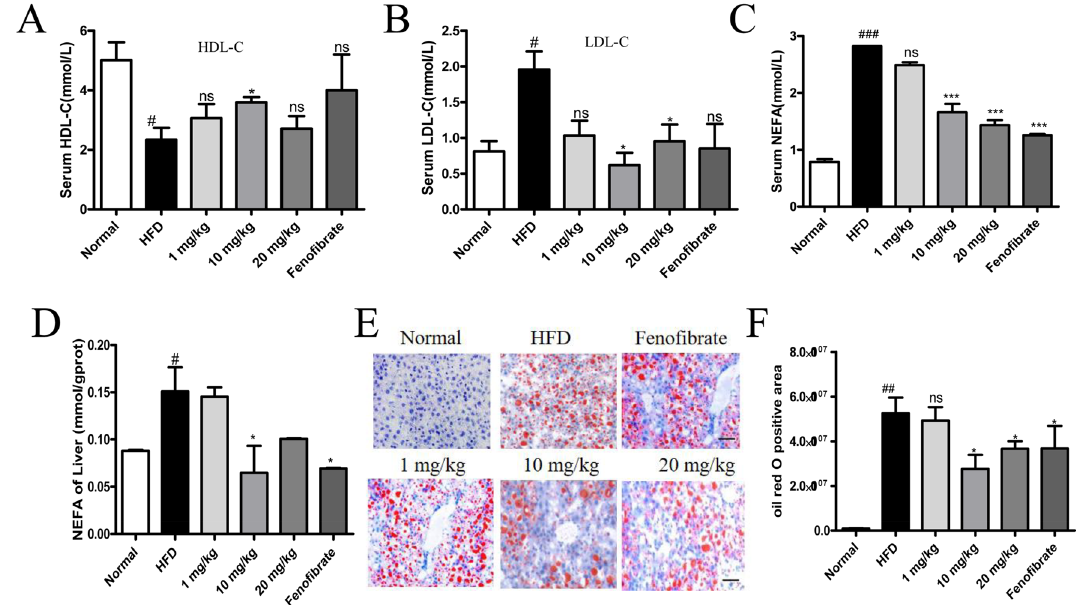
Figure 5. STVNa improves lipid metabolism in NAFLD rats. ( A , B ) The levels of HDL-C and LDL-C. ( C , D ) The levels of NEFA in blood and liver tissue. ( E ) ORO-stained sections HFD-fed rats treated with/without STVNa. Scale bar = 50 µm. ( F ) Positive ORO-stained areas. Mean ± SEM. * P < 0.05 vs. HFD-fed rats; # P < 0.05 vs. ND-fed